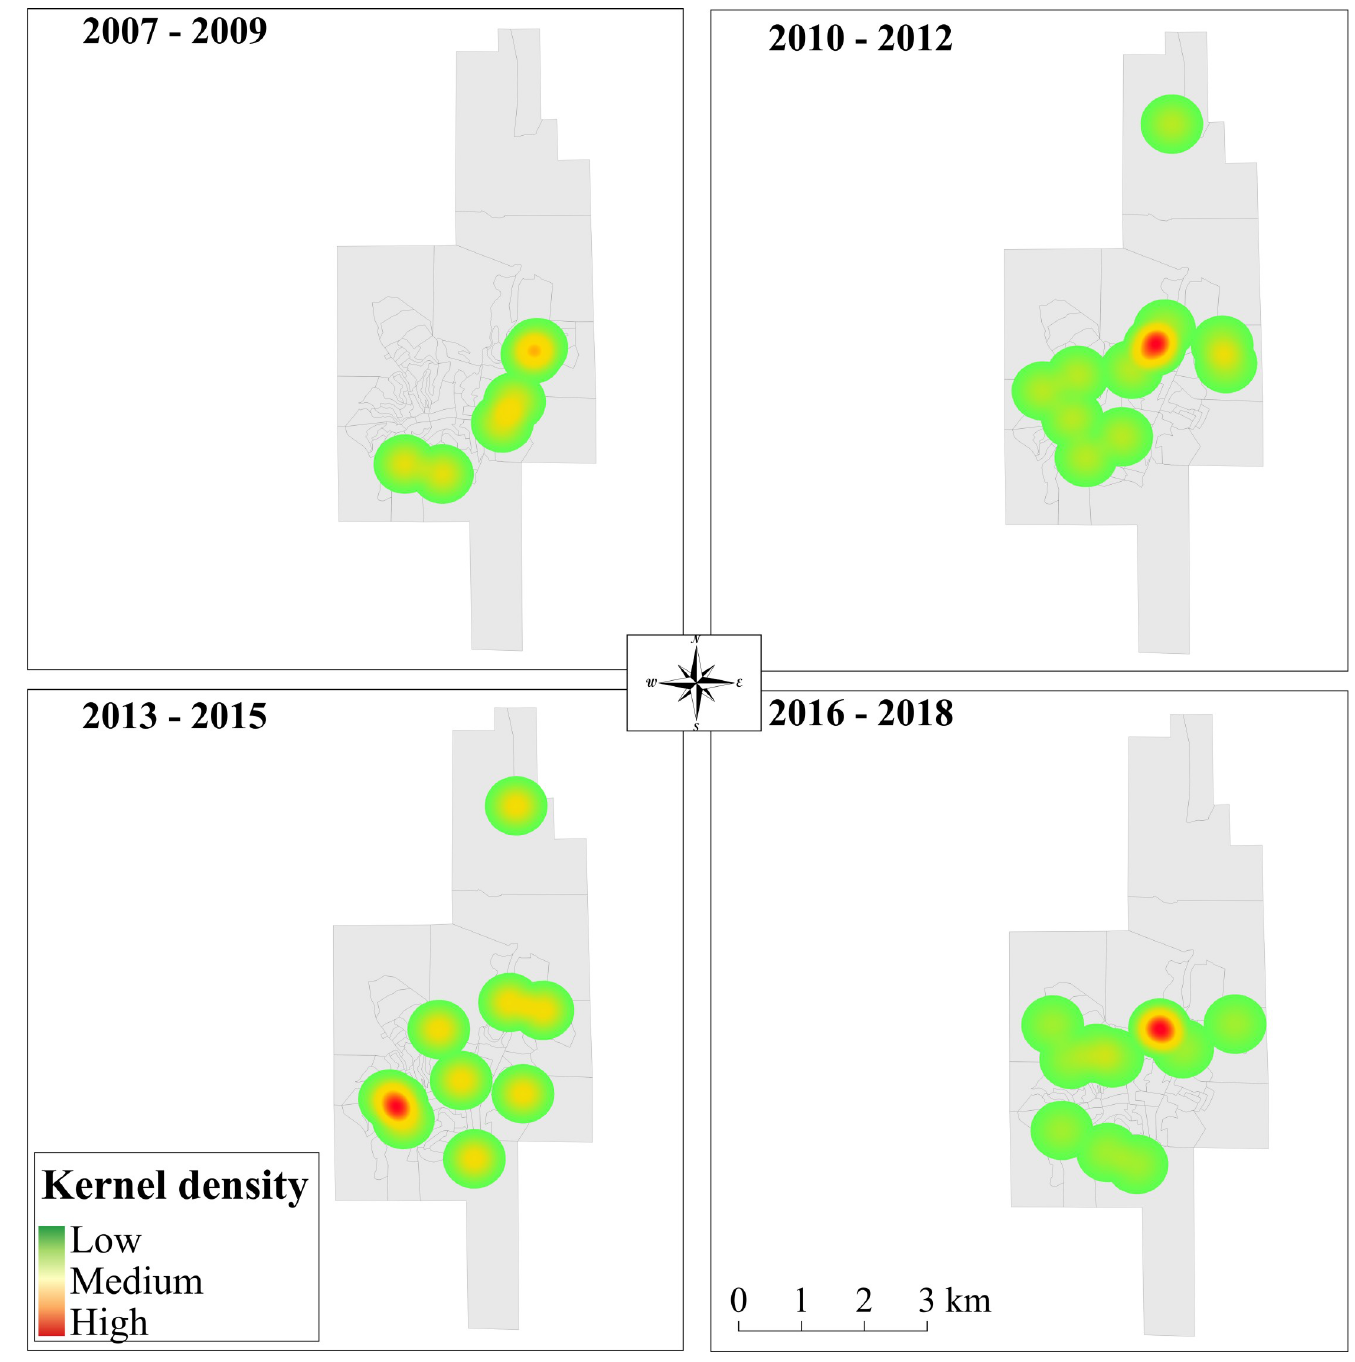
Fig 7. Kernel density of cases of ATL in the city of Caratinga